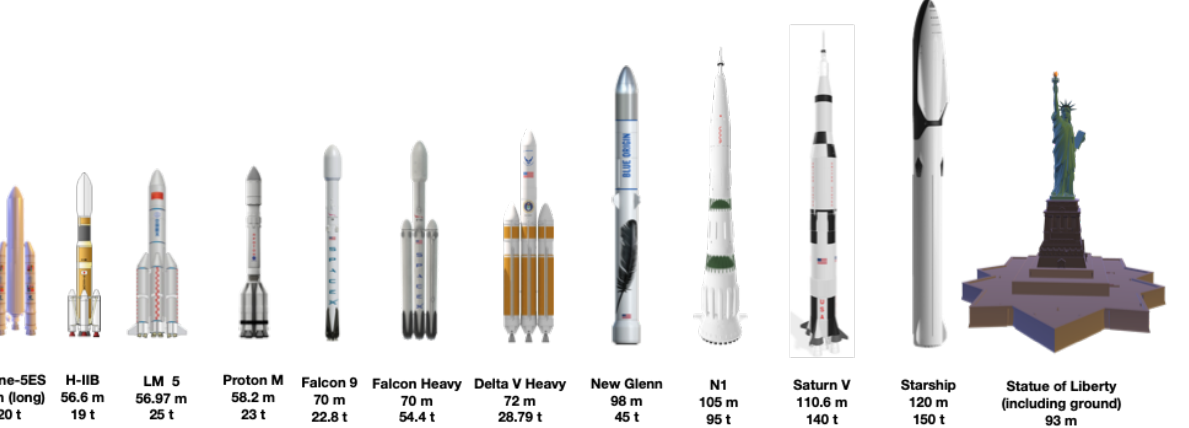
Figure 6. Payload to LEO comparison of several worldwide launch vehicles, based on concept and data in